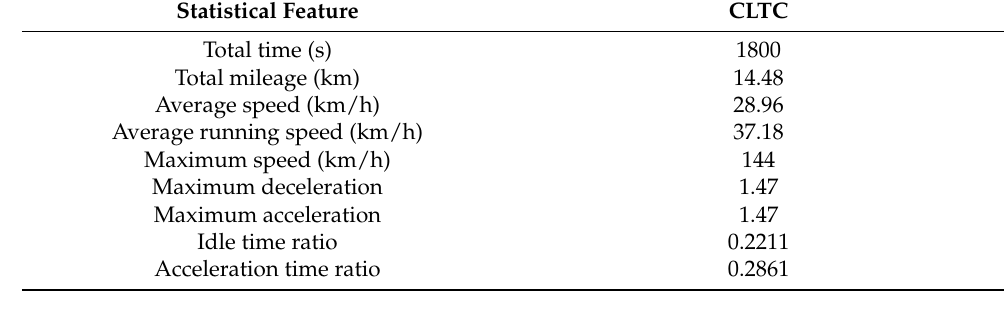
Table 6. CLTC data in typical Chinese cities.